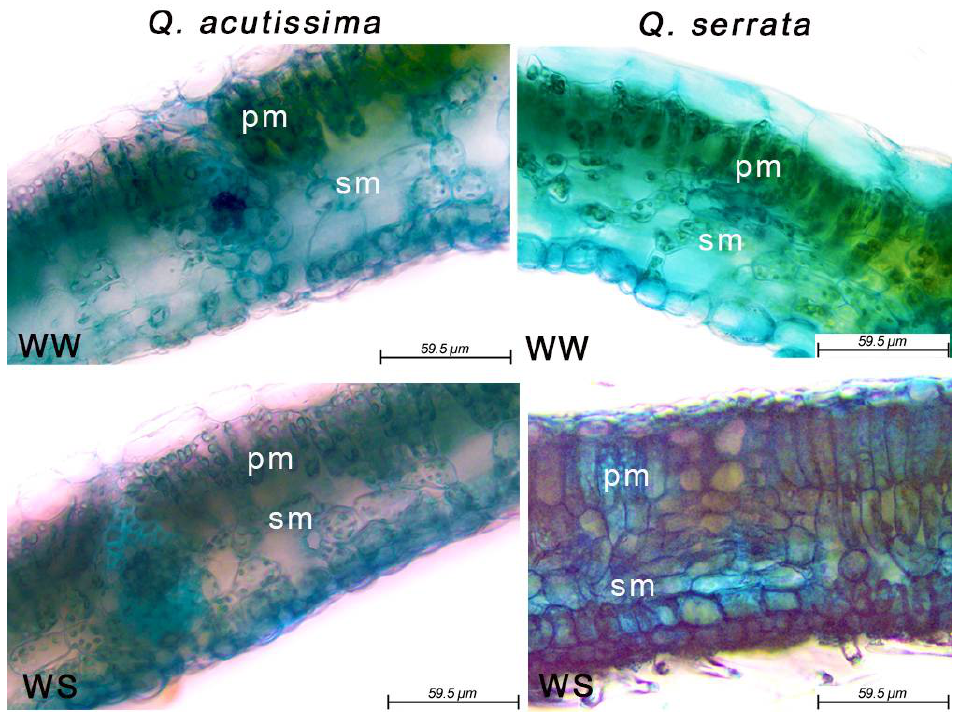
Figure 5. Changes in leaf anatomical structure of Quercus acutissima and Q. serrata showing the palisade mesophyll (pm) and spongy mesophyll (sm) tissues in well-watered (WW) and water-deficit stress (WS) treatments at the final week.